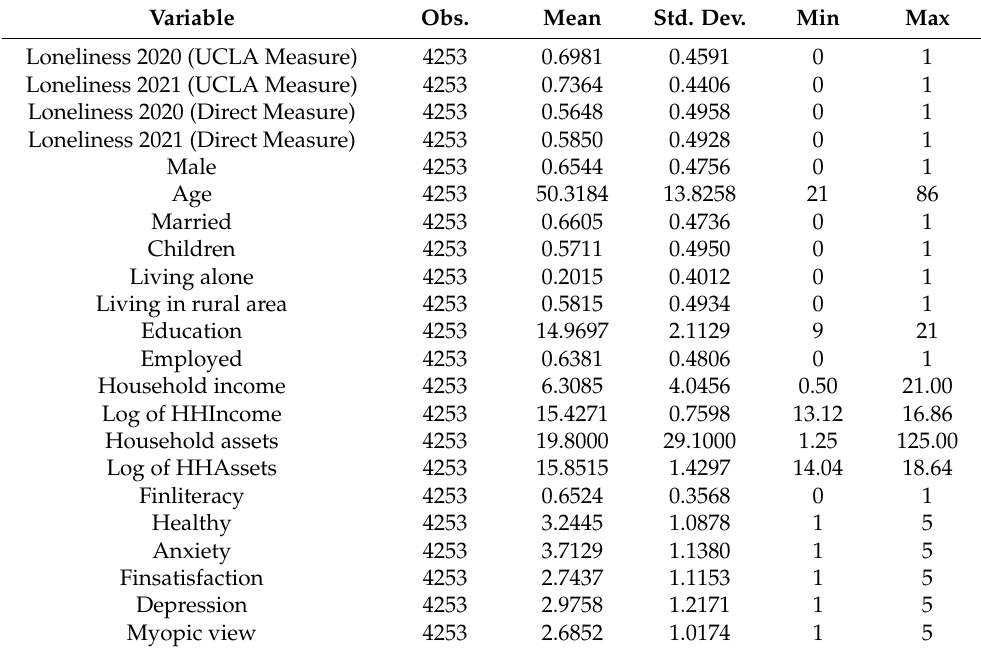
Table 2. Descriptive Statistics.